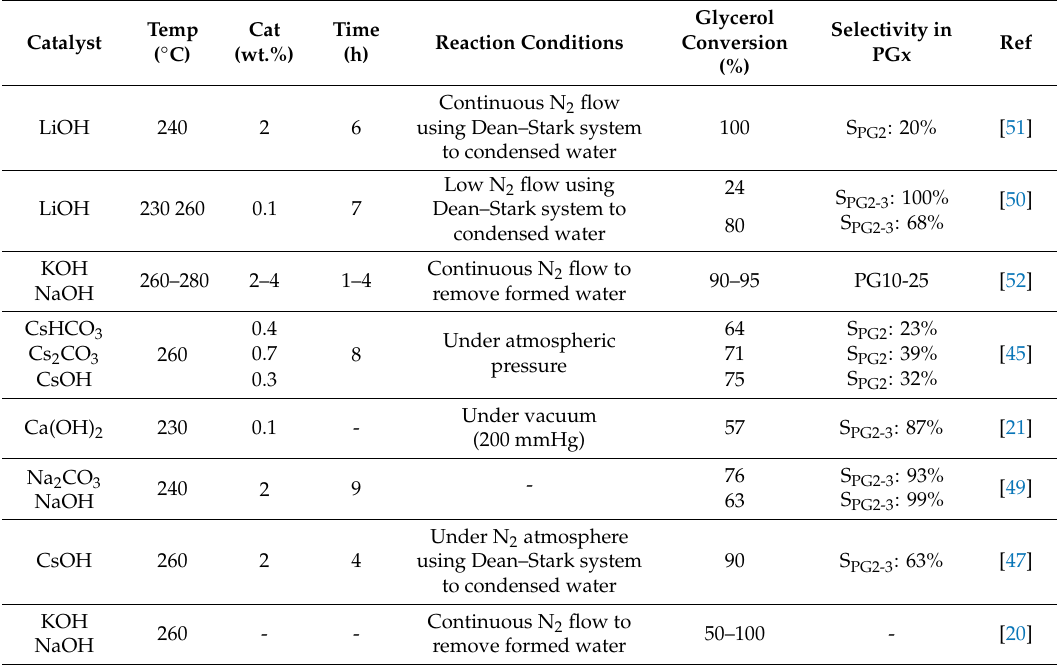
Table 2. Summary of the conditions and performances obtained for glycerol polymerization over homogenous